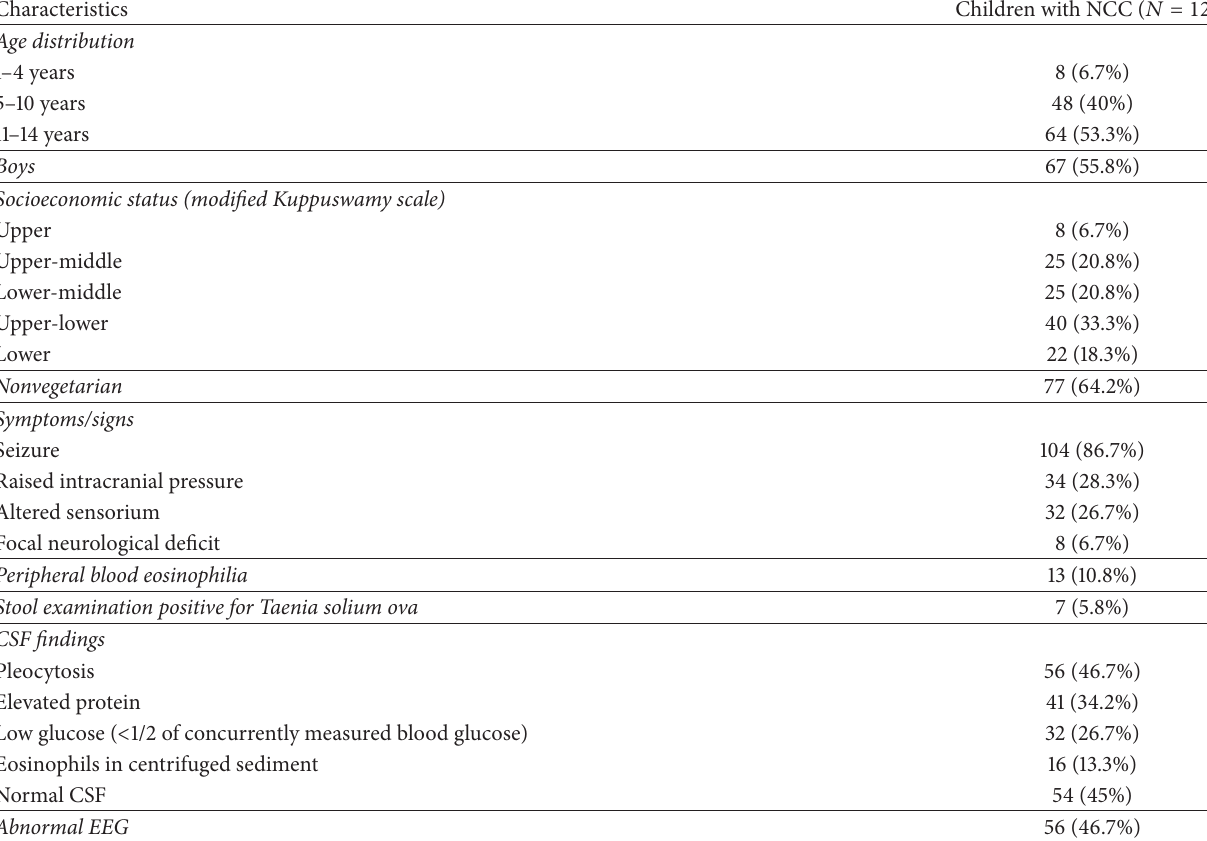
Table 1: Baseline characteristics and investigations in children with NCC ( 𝑁 = 120 ).